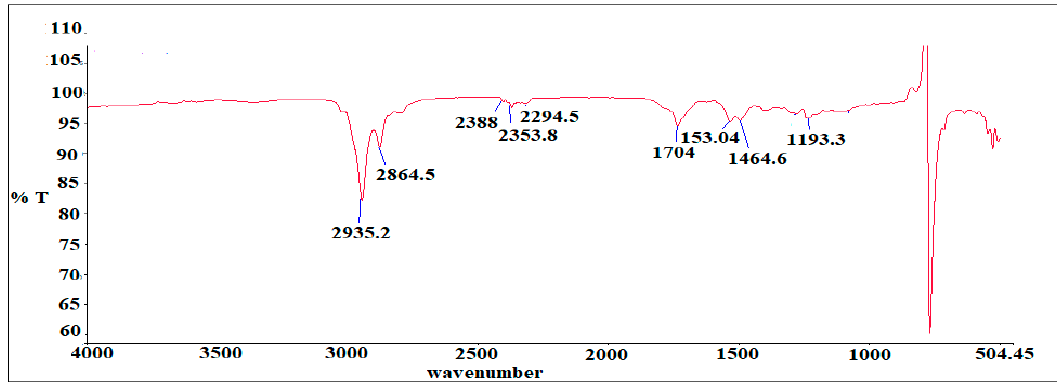
Figure 5. IR spectrum of as ‐ synthesized surfactant in hyphenated TG ‐ IR (curve 1).